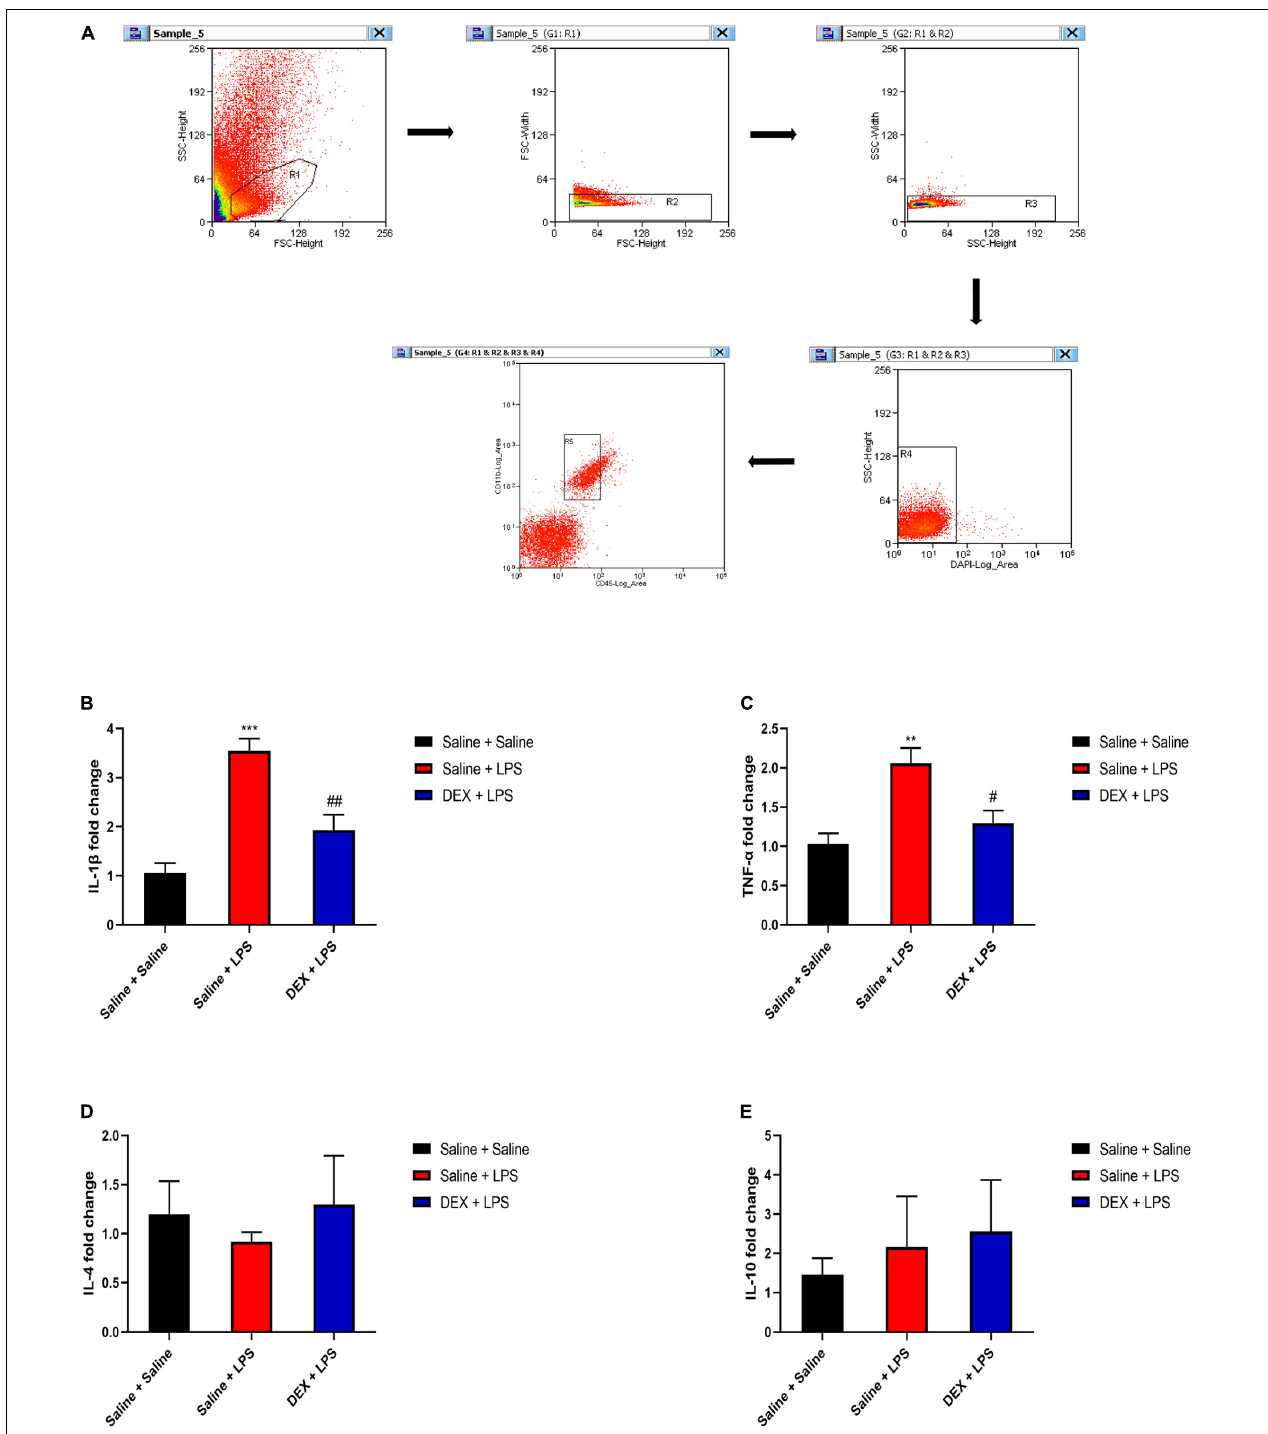
FIGURE 7 | DEX pretreatment attenuated the LPS-induced expressions of pro-inflammatory cytokines in microglia. (A) The representative sorting strategy of microglia from lumbar enlargement of the spinal cord in neonatal rats. Microglia were considered as CD45 low CD11b + cells in the R5 area and were gathered for mRNA analysis. (B,C) LPS induced increased mRNA levels of IL-1 β and TNF- α . DEX pretreatment decreased LPS-induced mRNA levels of IL-1 β and TNF- α . (D,E) Neither LPS nor DEX induced significant changes in the mRNA expressions of IL-10 and IL-4. Results are expressed as the mean ± SEM, n = 4 animals for each group, and were analyzed by one-way ANOVA followed by Tukey’s multiple comparisons test or Kruskal–Wallis test followed by Dunn’s multiple comparisons test.** P < 0.01, *** P < 0.001, Saline + LPS group vs. Saline + Saline group. # P < 0.05, ## P < 0.01, DEX + LPS group vs. Saline + LPS group.